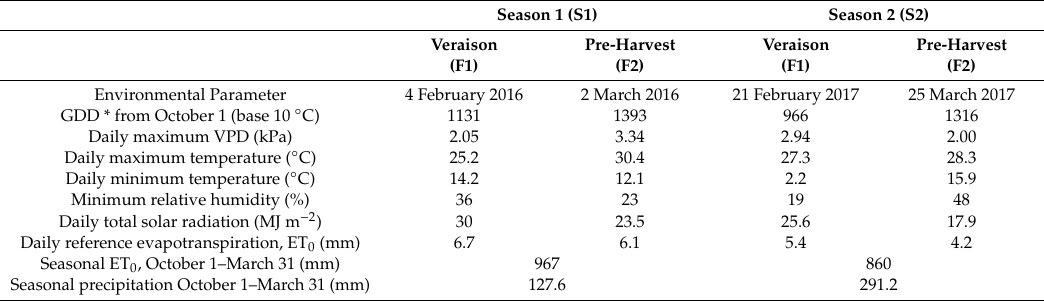
Table 1. Climatic conditions associated with four flights as referenced from Bureau of Meteorology in Coonawarra (weather station ID: